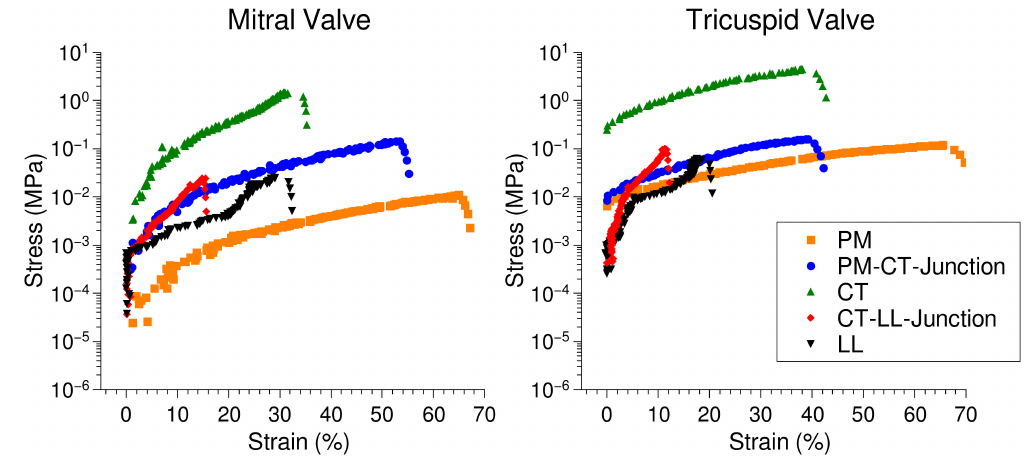
Figure 5. Stress vs. strain evaluation of individual sample segments from MV and TV bisected samples so as to measure these properties in the transition regions in addition to that of pure regions connected to the transition. Stress vs. strain plots were calculated by tracking the movement of fiducial marker. The PM is the most compliant element in the assembly, assuming most strain over the least amount of stress. The CT is the most tensile element, assuming least strain for most stress. The PM–CT junction, in both valves, has the second highest stress for strain. Several points were recorded after the beginning point of sample failure showing the steep decline in the plot of strain vs. stress for each component. These data were used to help determine the ultimate tensile strength (stress) of each tissue component.